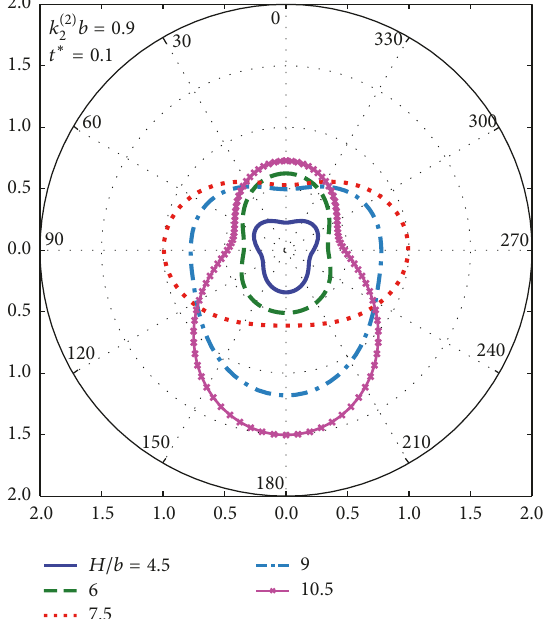
Figure 12: Radial displacement (𝑢 ∗ 𝑟 ) versus polar angle at 𝑟 = 𝑏 for different depths (𝐻/𝑏) for a tunnel in soft soil.